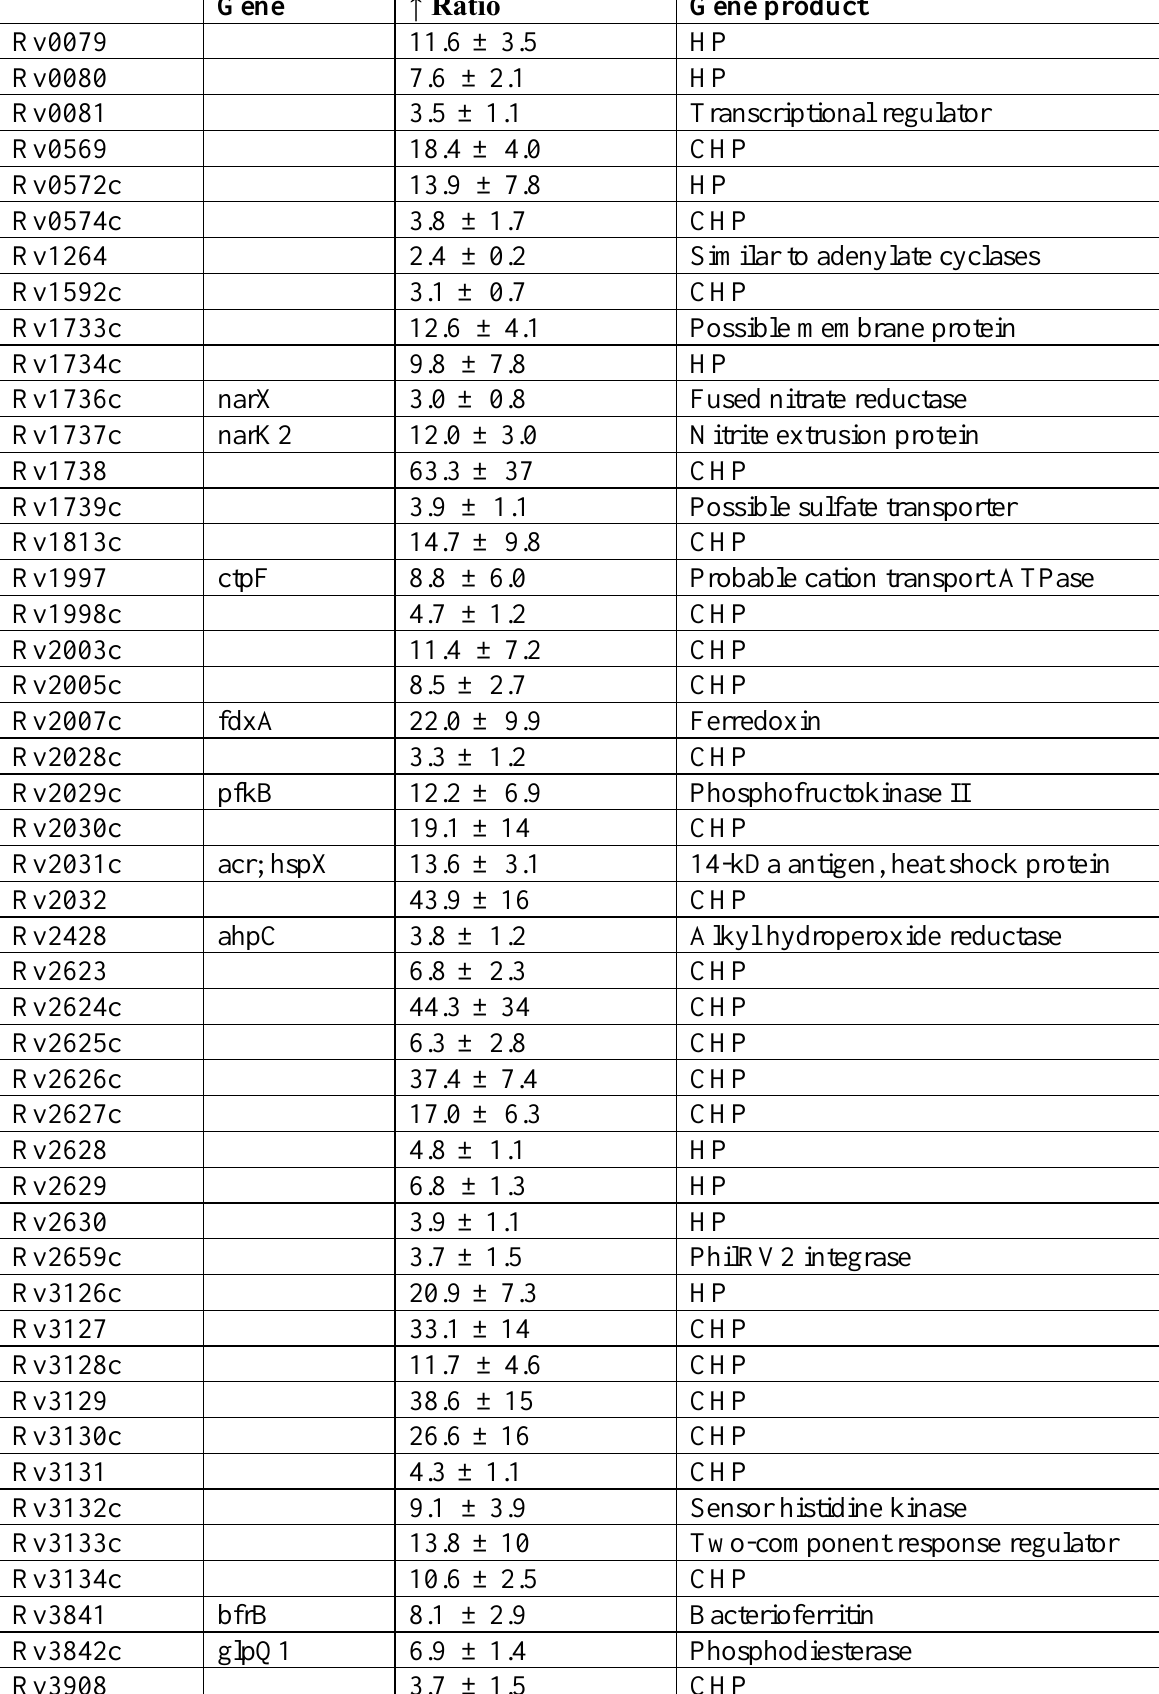
Table 1. List of Mtb genes induced under hypoxia